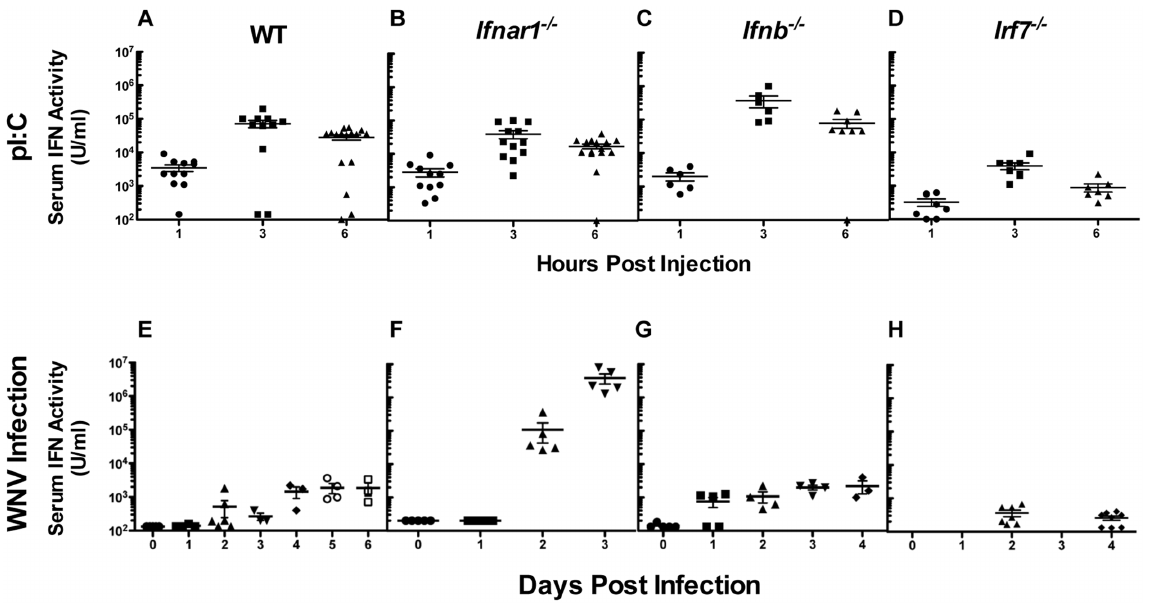
Fig 5. Kinetics of native type I IFN production in vivo . Wild-type ( A, E ), Ifnar1 -/- ( B, F ), Ifnb -/- ( C, G ) or Irf7 -/- ( D, H ) mice were treated with 100 μ g of pI:C ( A-D ) or infected with 10 2 PFU of WNV ( E-H ) and serum was assayed on the indicated times for IFN activity by VSV CPE bioassay. Samples from three independent sets of pI:C treated mice (3 to 5 per group) were collected at 1, 3 and 6 h post injection. Serum from groups of 3 to 8 mice of each genotype was collected from na ï ve and WNV infected mice at days 1 to 6 post infection. Each genotype was sampled from at least two ( Ifnar1 -/- and Irf7 -/- ) or more (wild- type and Ifnb -/- ) independent infections. IFN levels in all samples were determined at least three times. As shown herein, symbols represent samples derived from individual animals at the times indicated and assayed at the same time.